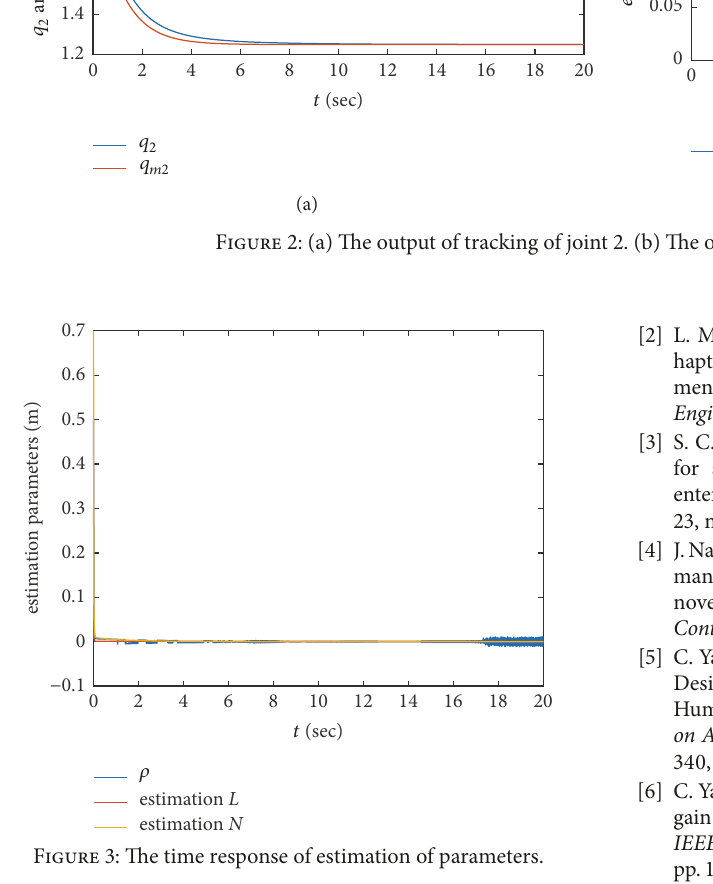
synthesize fuzzy controller. The final simulation example has shown the effectiveness of the design method in this